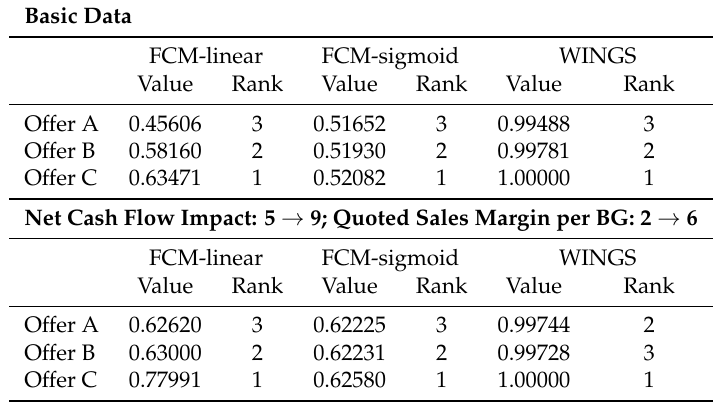
Table 4. FCM and WINGS Financial Effect—results of sensitivity analysis.